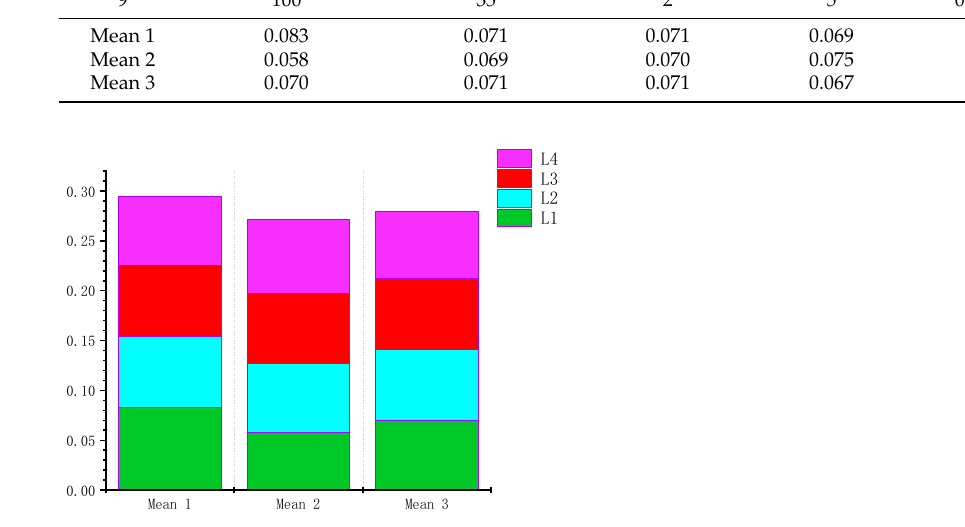
Figure 17. Five-factor three-level average comparison.